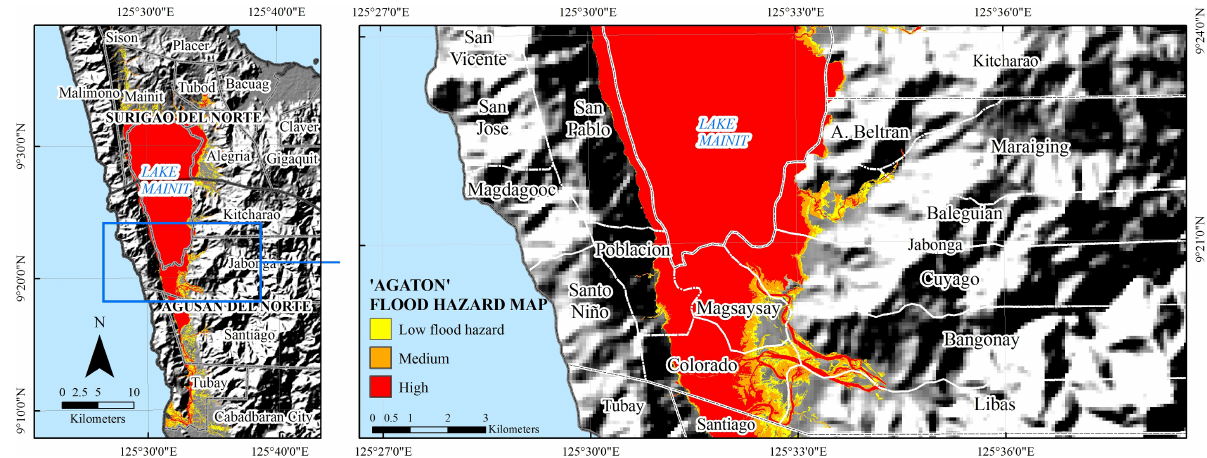
Figure 2: Flood hazard map of Jabonga for the Agaton event.